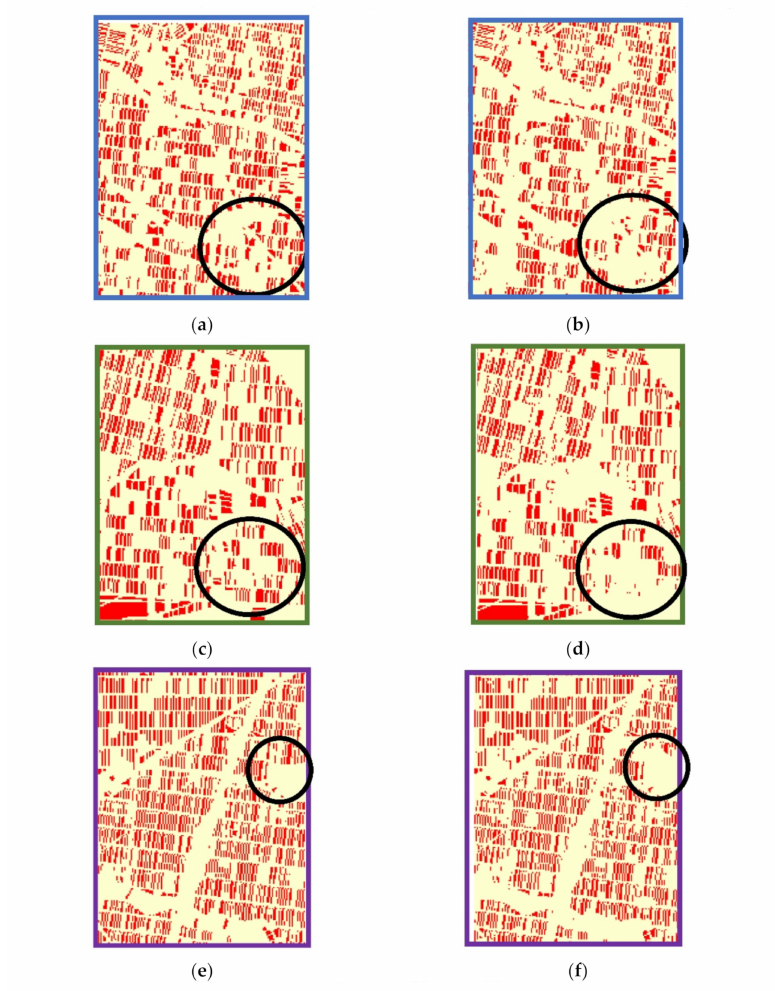
Figure 12. Comparing the detection results of selected regions with ground truth data of the selected regions from Figure 11. ( a , c , e ) are ground truth data; ( b , d , f ) are rice-fields